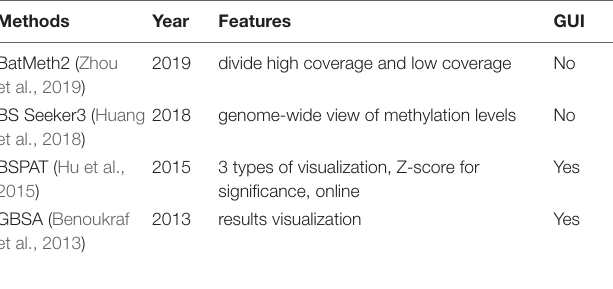
TABLE 3 | Methylation level scoring tools for bisulfite